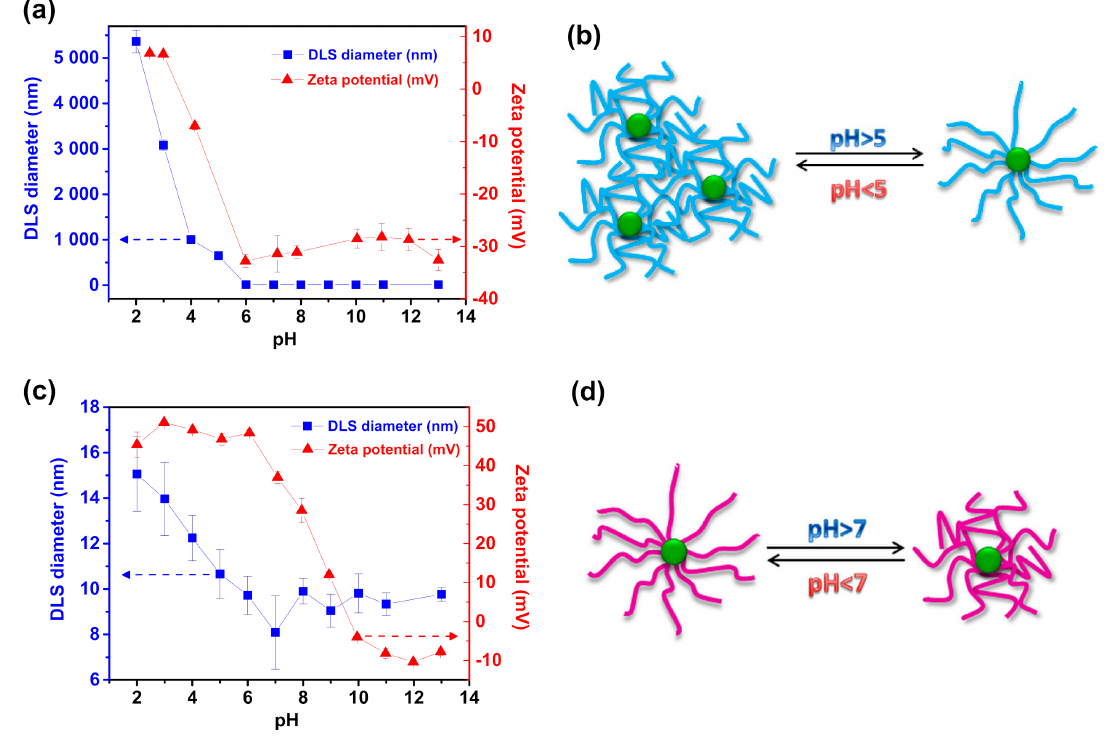
Figure 4. Effect of varying pH on number average sizes and zeta potential of the troxerutin-based macromolecules with ( a ) PAA and ( c ) PDMAEMA side chains; Scheme of pH-responsive behavior of ( b ) PAA and ( d ) PDMAEMA composed macromolecules with troxerutin core. The measurements conducted for final product from the syntheses shown in Table 1, entry 3 and 4,